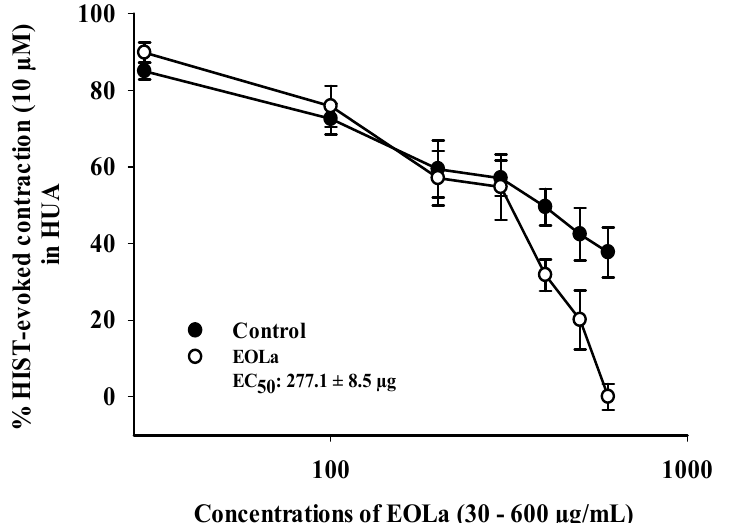
Figure 4. Relaxant effect of EOLa (30–1000 µ g/mL) and evaluation of pharmacomechanical coupling by HIST (10 μ M) in HUA. “Log ‐ normal” plot for the effect of EOLa on contractions induced by histamine in HUA. Values are expressed as the mean ± SEM; n = 6 ( p < 0.01, one ‐ way ANOVA).